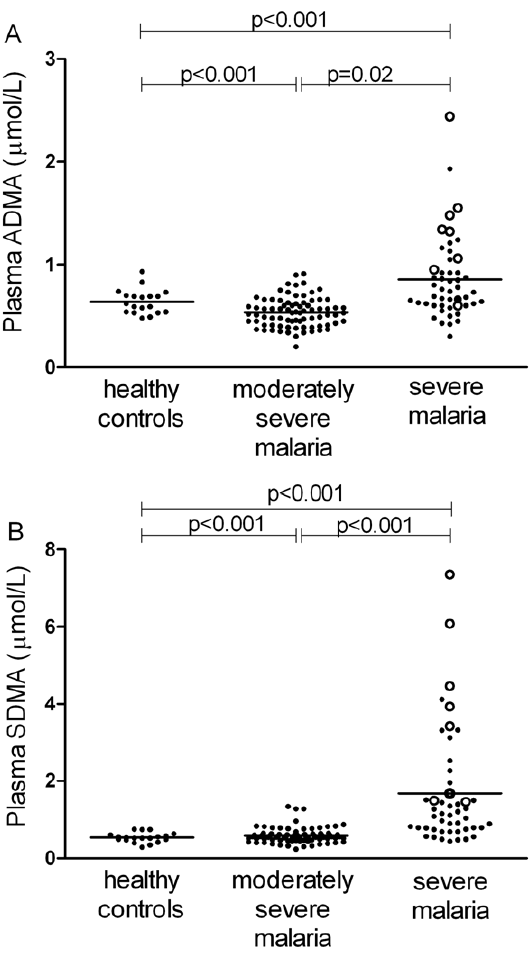
Figure 3. Longitudinal course of plasma ADMA concentrations and L-arginine/ADMA ratio in patients with severe malaria. Mean values (circles) and 95%CI (bars) are displayed at each time point. Values from day 5–14 indicate mean of all values obtained during this period. X axis values show time from start of anti-malarial therapy. Numbers indicate patients examined during each time period.